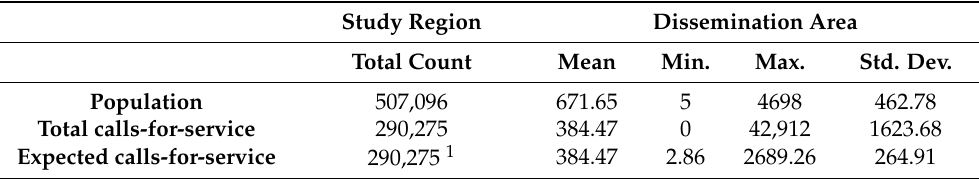
Table 1. Descriptive statistics for call-for-service counts in Waterloo Region,